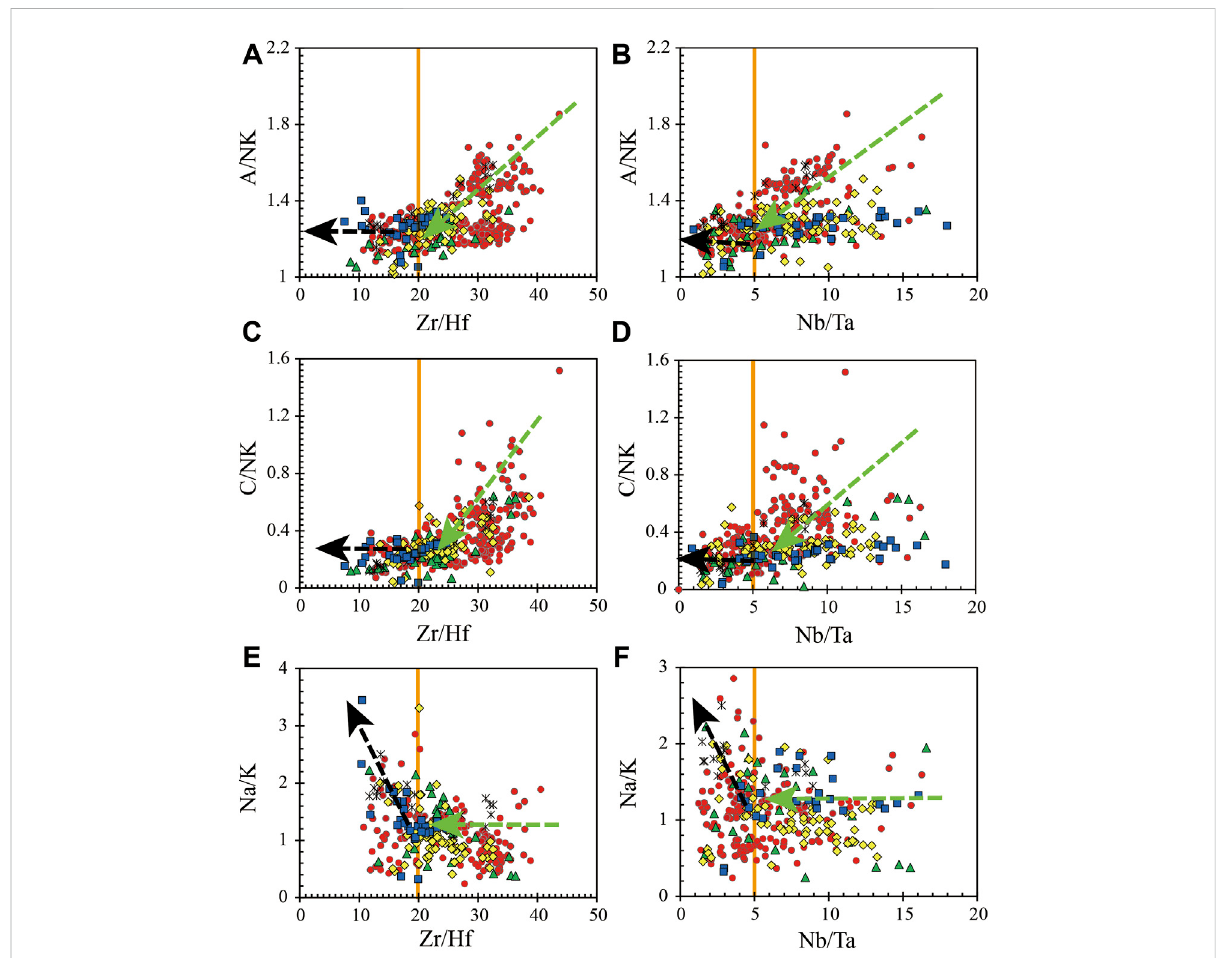
FIGURE 5 Relationship between thetextural change inthesilicamelts (represented byA/NK,C/NK, andNa/K)and high- fi eldstrength elements ’ ratios(Zr/ Hf and Nb/Ta). A/NK=Al 2 O 3 /(Na 2 O+K 2 O),C/NK=CaO/(Na 2 O+K 2 O),Na/K= Na 2 O/K 2 O